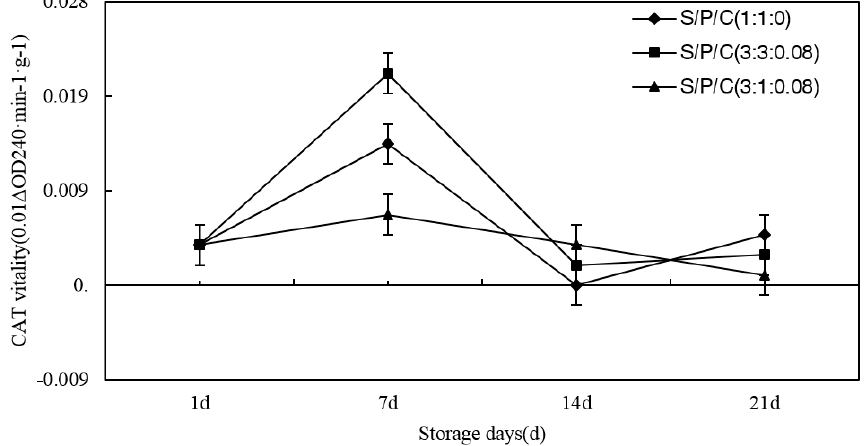
Figure 10. Effect of starch/polyvinyl alcohol/citric acid ternary blend functional food packaging films on the activity of CAT.